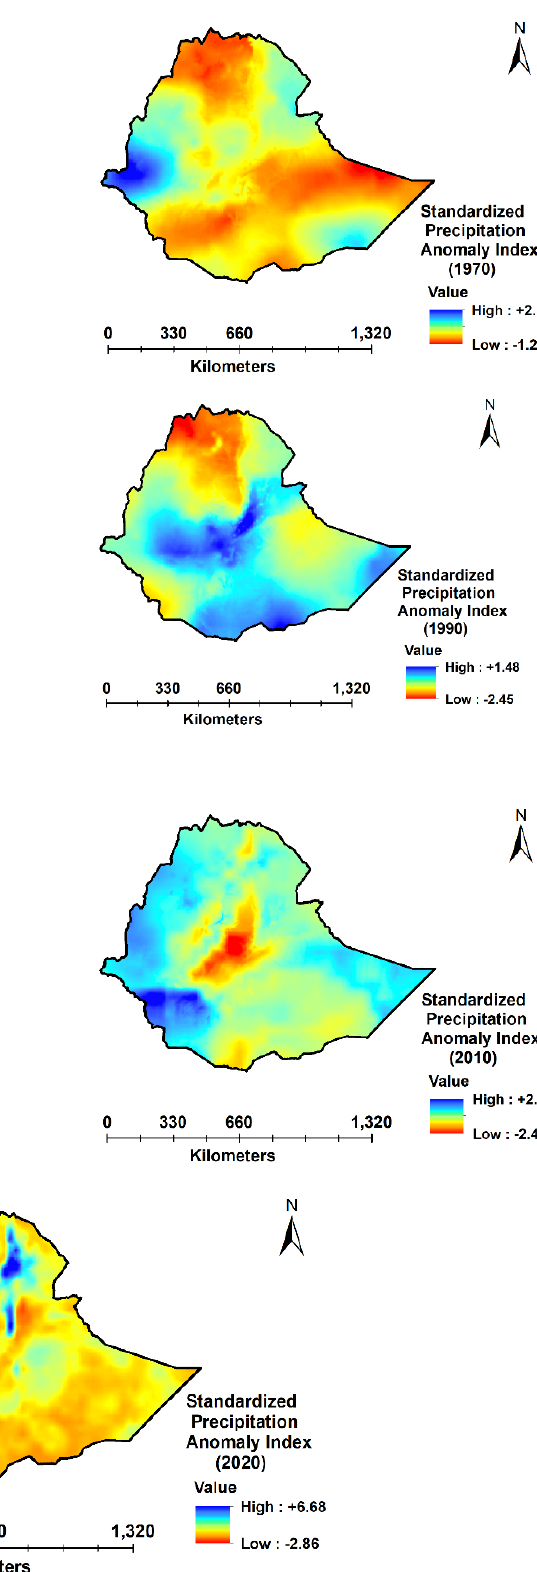
Figure 4. Standardized precipitation anomaly index maps for 1960, 1970, 1980, 1990, 2000, 2010, and 2020 in the study of Ethiopia. 2020 in the study of